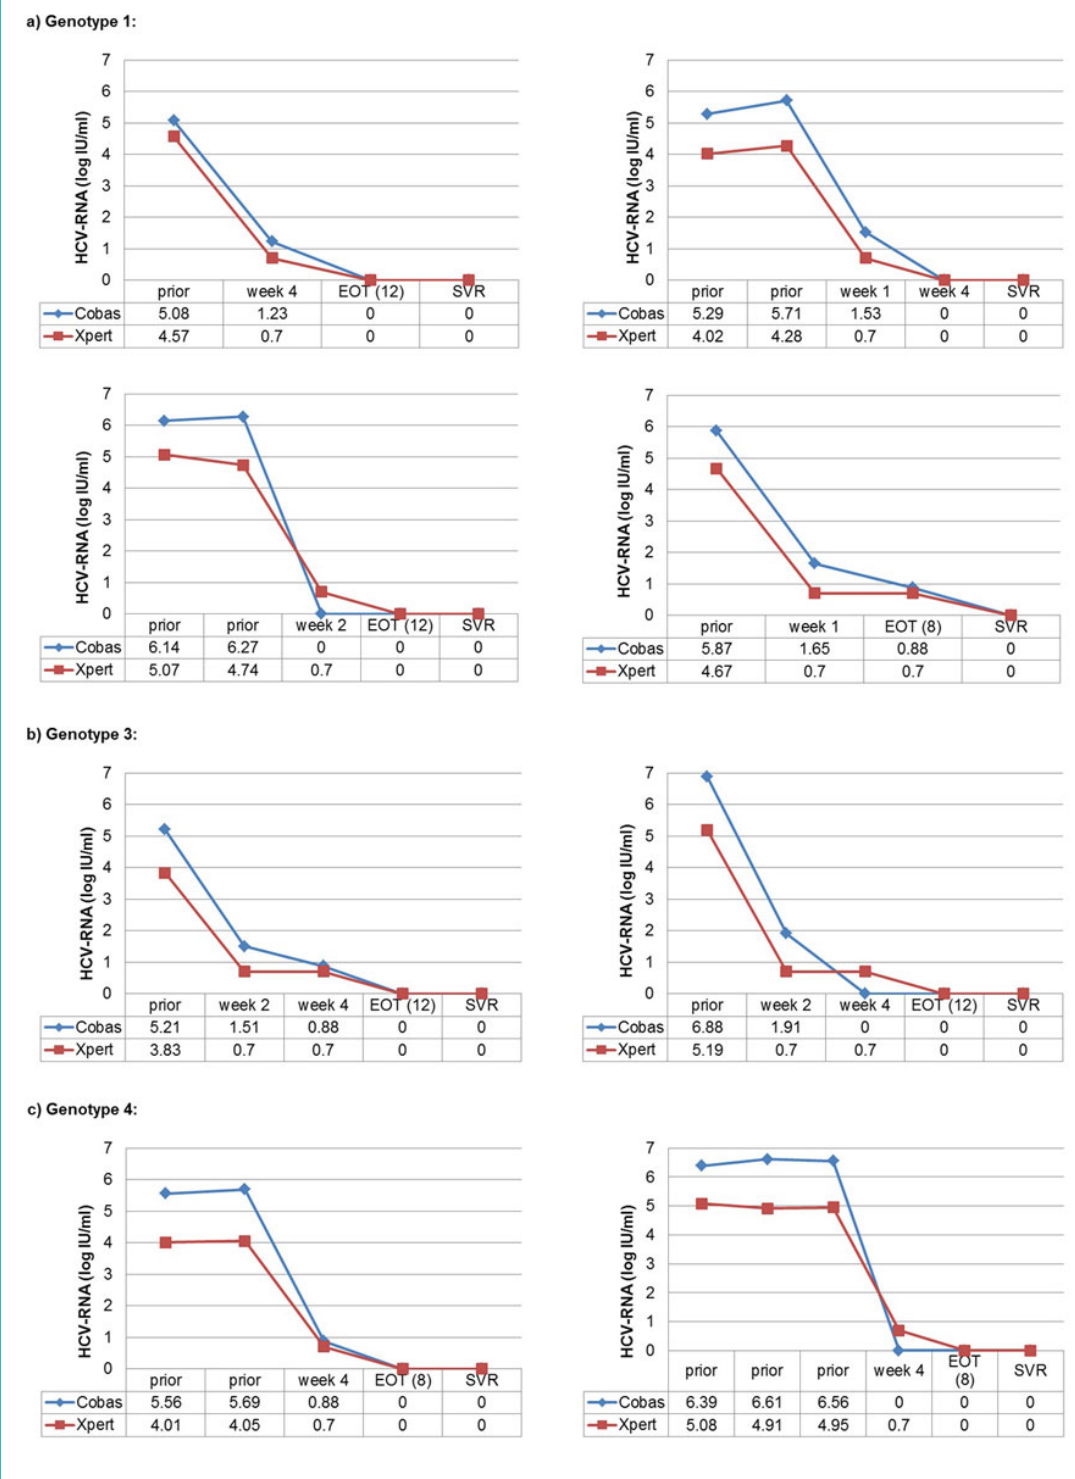
Figure 3: Xpert ® HCV Viral Load (VL) test: HCV RNA course for 10 patients with parallel values prior to, during and after HCV-treat- ment.Cobas = Cobas ® assay with 650 µl venous plasma (limit of quantification 15 IU/ml = 1.2 log IU/ml); Xpert = Xpert ® HCV Viral Load test with 100 µl finger-stick capillary whole blood (~55 µl plasma); prior = prior to HCV treatment; week 1, week 2, week 4, week 6 = respective weeks under HCV treatment; EOT (8) = end of treatment (week 8); EOT (12) = end of treatment (week 12); SVR = sustained virological re- sponse; 0 = HCV RNA not detectable.For unquantifiable positive Cobas ® results (“detectable below the limit of quantification of 15 IU/ml [1.2 log IU/ml]”), the mid-point between zero and the lower limit of quantification was used (7.5 IU/ml, 0.88 log IU/ml). For unquantifiable